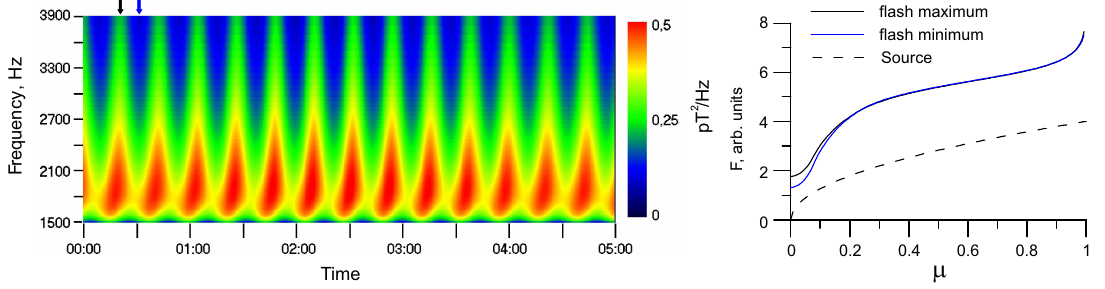
Fig. 3. Regime of self-sustained oscillations in the case of losses due to precipitation. The source of energetic particles is 10 times greater then in Fig. 1 ( J 0 = 10 7 cm − 2 s − 1 ), all other parameters and time marks legend are the same as in Fig. 1.